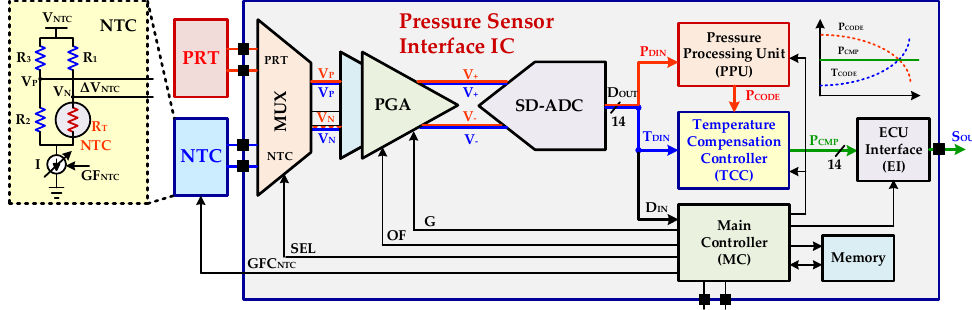
Figure 2. Automotive PRT pressure and temperature sensors signal interface integrated circuit (IC) with proposed polynomial based digital temperature compensation.